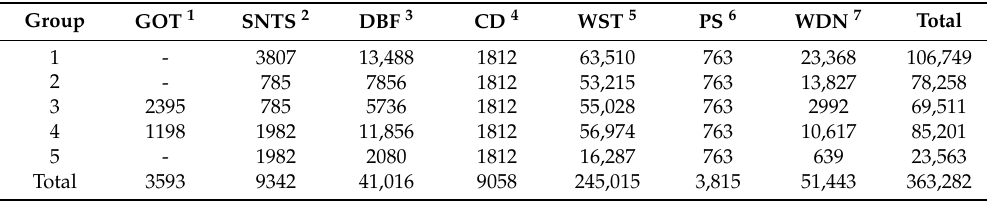
Table 8. Investment required for the implementation of the treatment systems for rainwater and greywater (US